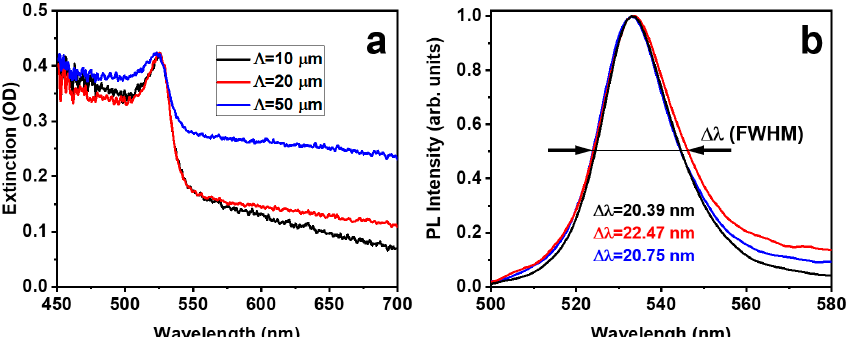
Figure 4. Absorption ( a ) and PL ( b ) spectra of the crystalline MAPbBr 3 film gridded at different periods. In ( b ), the bandwidth of each PL spectrum at FWHM is listed.